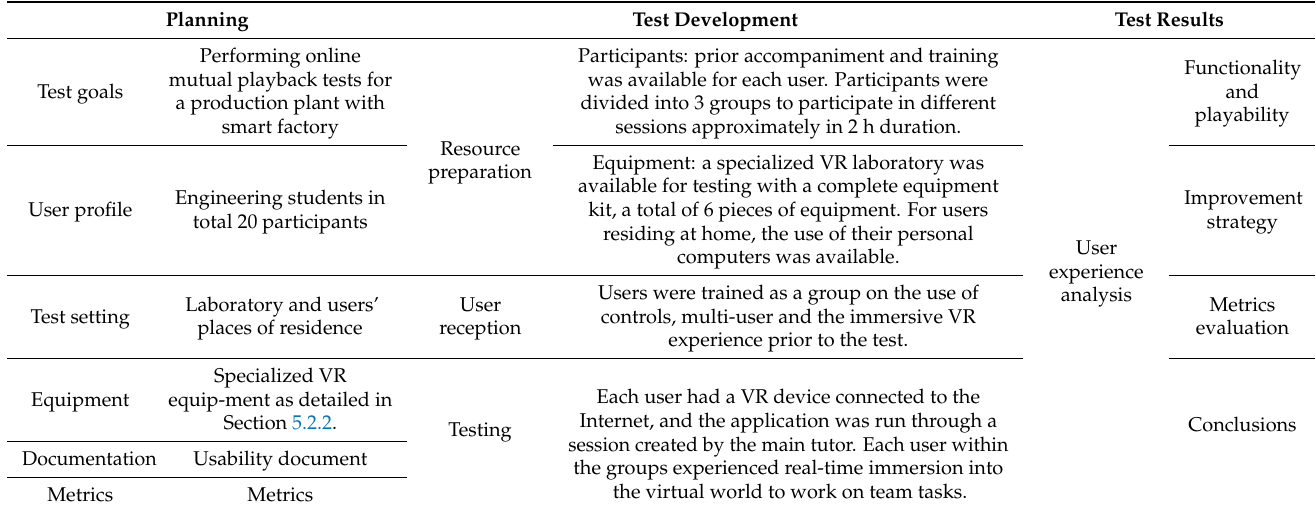
Table 2. VR Usability